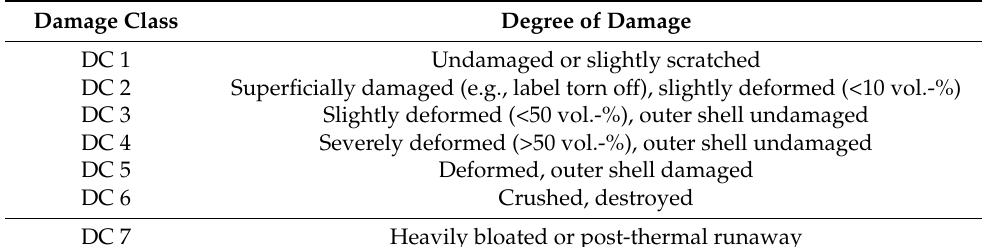
Table 4. Overview of damage classes and description of the degree of